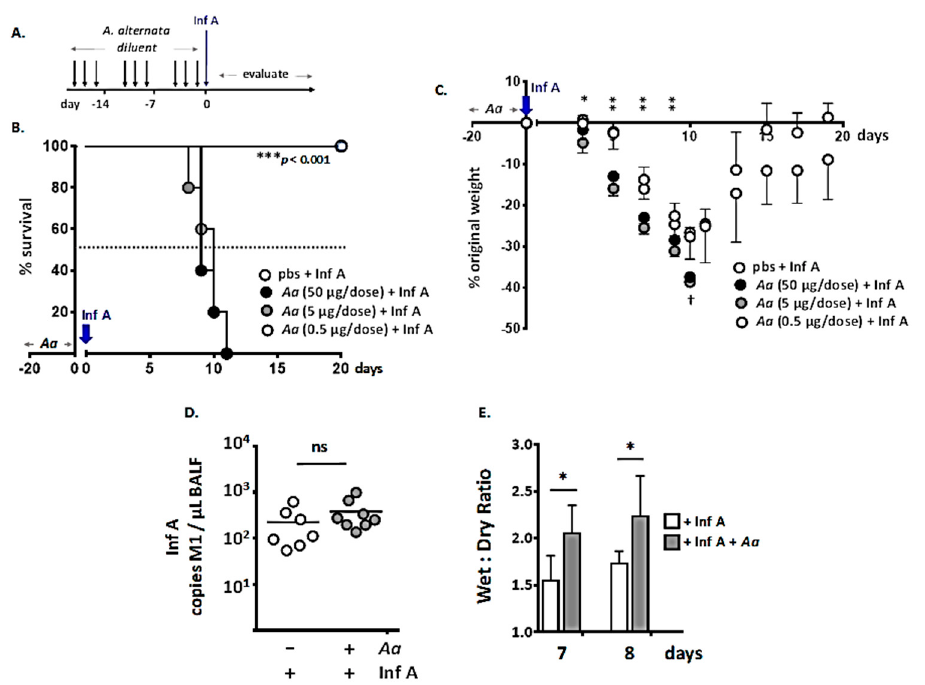
Figure 1. Repetitive administration of Alternaria alternata results in increased susceptibility to lethal Inf A infection. ( A ) Strategy: A. alternata at the nasal mucosa (0–50 µ g per inoculum; 2.5 µ L per nare) on days indicated followed by Influenza A / H3N2 (Inf A; 30 tissue culture infectious dose (TCID) 50 units per mouse, 2.5 µ L per nare) on day 0. ( B ) Survival in response to A. alternata followed by Inf A, as per the inoculation strategy in A.; n = 5 mice per group, *** p < 0.001, Kaplan–Meier log-rank. ( C ) Weight loss in response to A. alternata followed by Inf A as per the inoculation strategy in A.; n = 5 mice per group, * p < 0.05, ** p < 0.01, 1-way ANOVA; † no survival after this time point in response to the two highest doses of A. alternata as indicated. ( D ) Virus (copies virus M1 gene/ μ L bronchoalveolar lavage fluid [BAL]) determined by quantitative reverse transcription-polymerase chain reaction (qRT- PCR) on day 6 as per Figure 1A in mice treated with A. alternata (5 μ g per inoculum) or diluent only